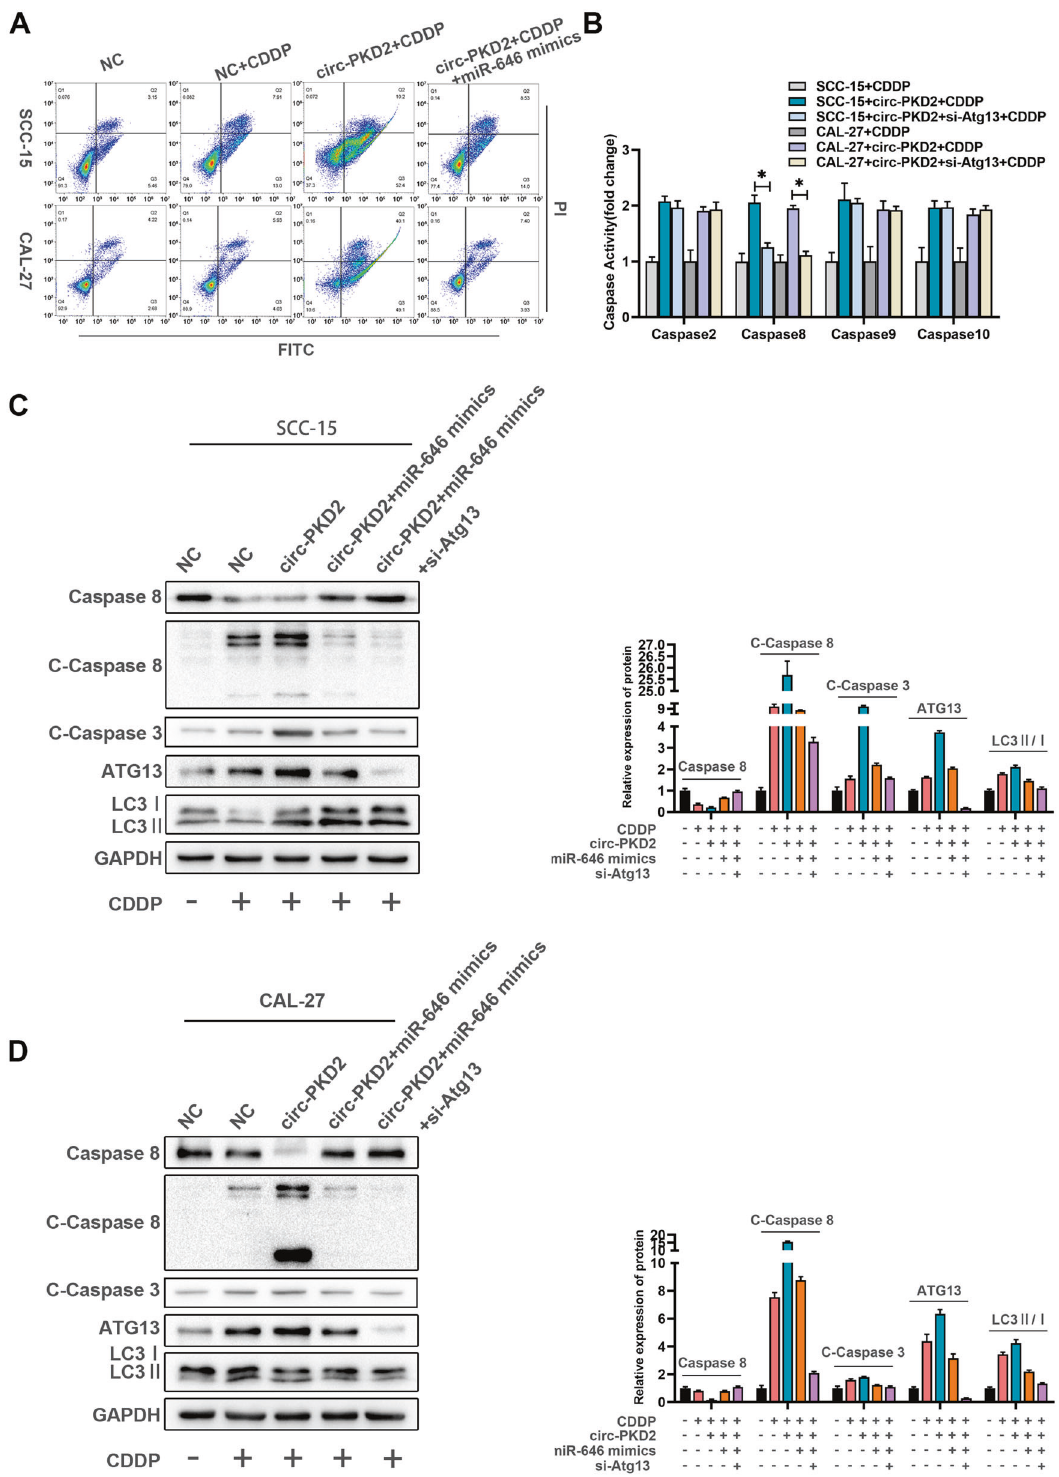
Fig. 4 circ-PKD2 activated caspase-8 through Atg13 to increase the sensitivity of oral squamous carcinoma cells to cisplatin. A Flow cytometry results showing the apoptosis rate of cells transfected with circ-PKD2 overexpression, circ-PKD2 + miR-646 mimics, and circ- PKD2 + miR-646 mimics + si-Atg13. B Real-time PCR results showing the caspases ’ activities. C Western blotting results showing the activation of caspase-8, caspase-3, ATG13, P62, and LC3B in SCC-15 cells transfected with circ-PKD2 overexpression, circ-PKD2 + miR-646 mimics, and circ-PKD2 + miR-646 mimics + si-Atg13. D Western blotting results showing the activation of caspase-8, caspase-3, ATG13, P62, and LC3B in CAL-27 cells transfected with circ-PKD2 overexpression, circ-PKD2 + miR-646 mimics, and circ-PKD2 + miR-646 mimics + si-Atg13. * p < 0.05, ** p <